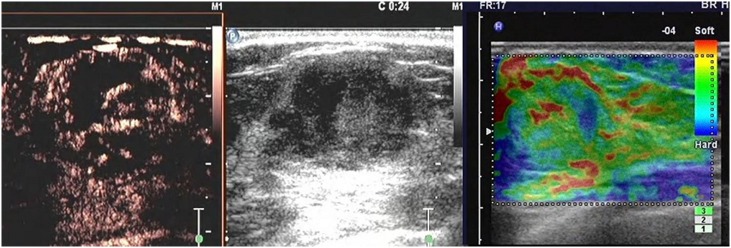
A lesion was categorized as BIRADS 4B, with a score of 1 by elastography, and with a score of 3 by CEUS 5-point scoring system.The pathological result of the lesion was mucinous carcinoma.